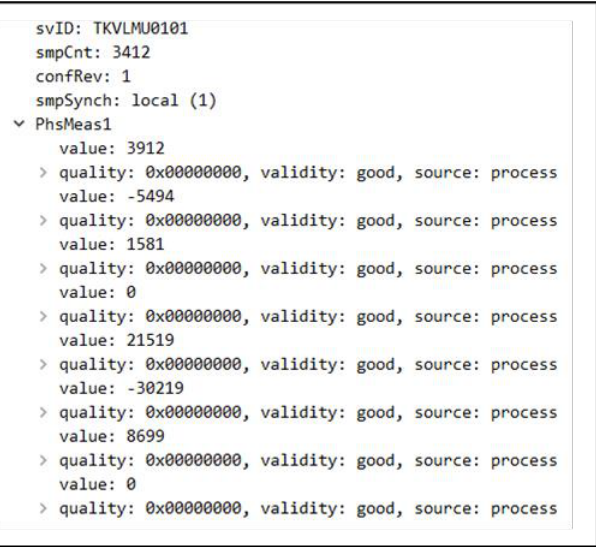
Figure 1. SV packet captured in Wireshark software.